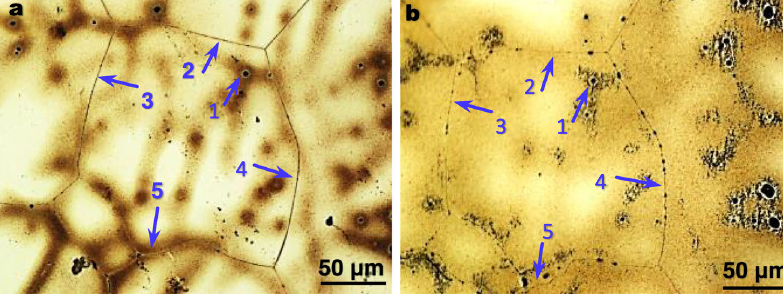
Fig.5|ThermalstabilityofmigratedSGBsintheMg-0.63at.%Snalloy.a As-cast grain structures with migrated and non-migrated normal SGBs, where arrow 1 was chosen as the reference point; arrows 2 – 4 indicate the four SGBs that underwent migration; and arrow 5 points to a normal curved SGB that did not exhibit